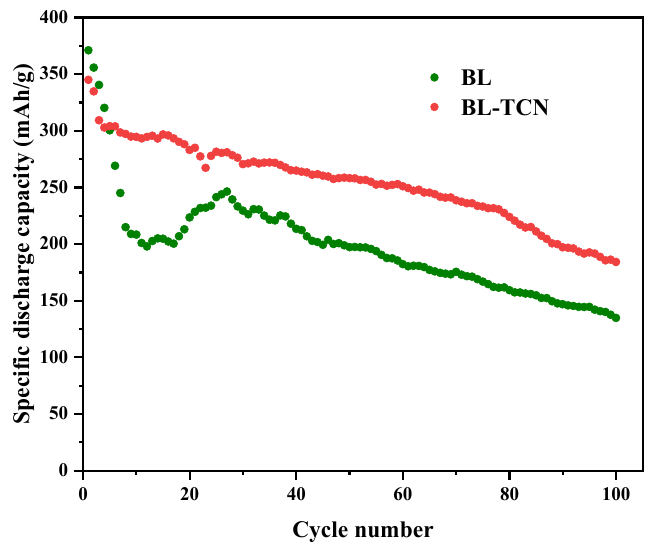
Figure 1. Cycle performance of cells under different electrolyte formulations.